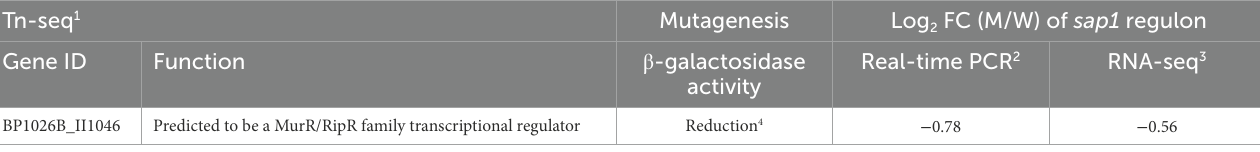
TABLE 1 Summary of experimental data indicating that SapR positively regulates sap1